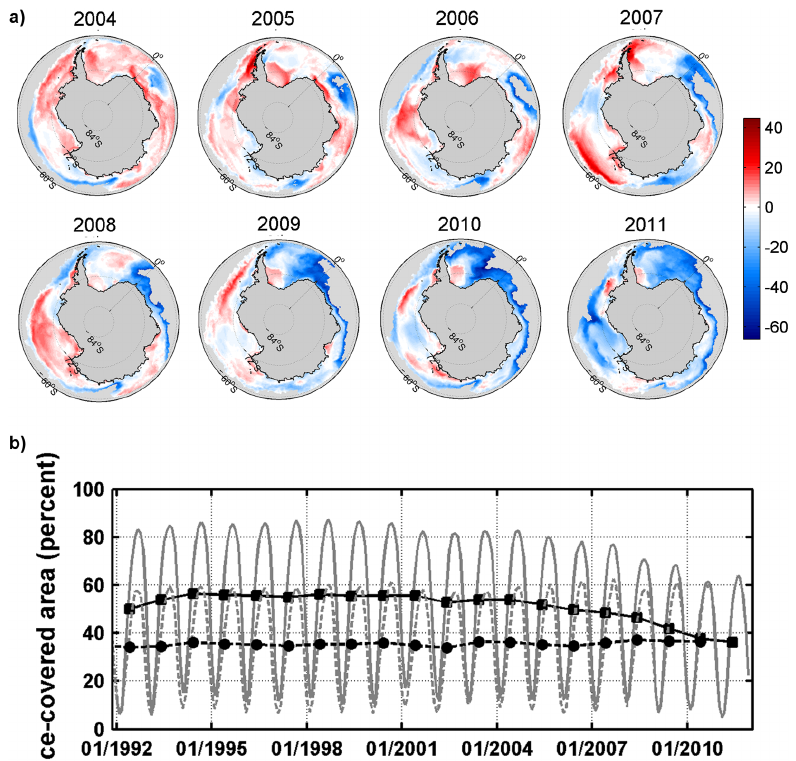
Figure 4. (a) ECCO2 sea ice area (%) annual anomalies relative to the long-term (1992–2011) average for the period 2004–2011. (b) Com- parison of monthly (gray) and annual (black) time series of sea ice area (%) from the ECCO2 (solid line) and remote sensing (dashed line)